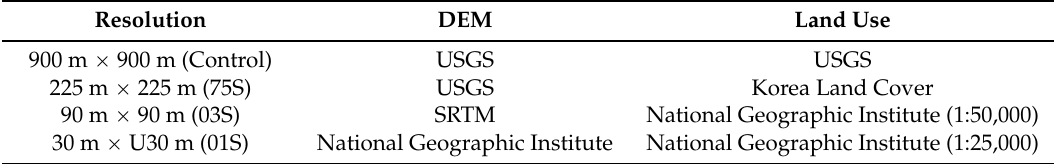
Table 2. Descriptions of the digital elevation model (DEM) and land use for model